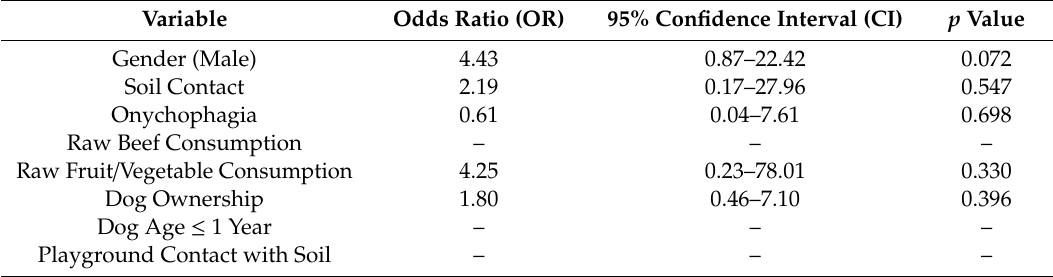
Table 2. Logistic regression analysis of Toxocara spp. seropositivity among the studied schoolchildren ( n = 88).